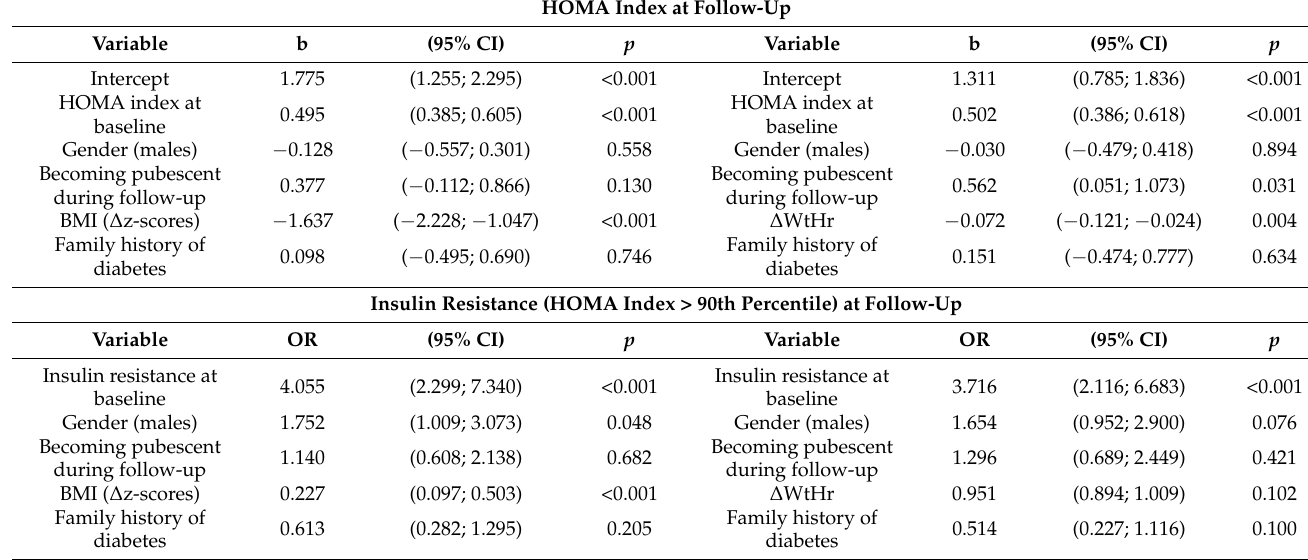
Table 3. Effect of HOMA index at baseline, gender, transition from pre-pubescent to pubescent, BMI or WtHr, family history of diabetes on HOMA index at follow-up by a multiple linear regression model. Effect of insulin resistance at baseline, gender, transition from pre-pubescent to pubescent, BMI or WtHr, family history of diabetes on insulin resistance at follow-up by a multiple logistic regression